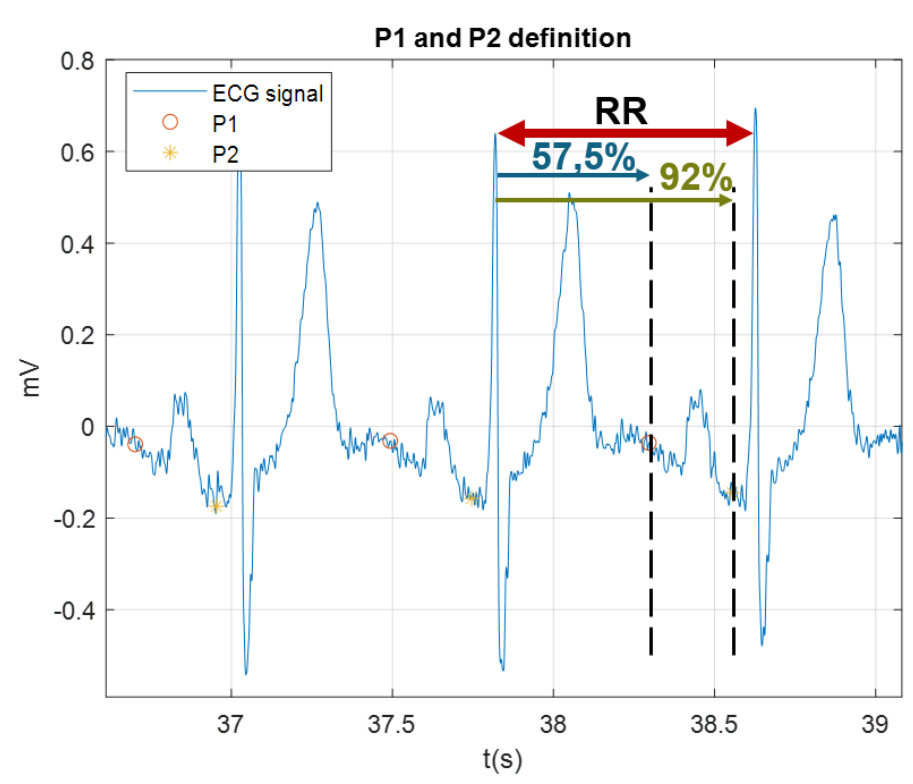
Figure 3. Methodology of P wave segmentation.